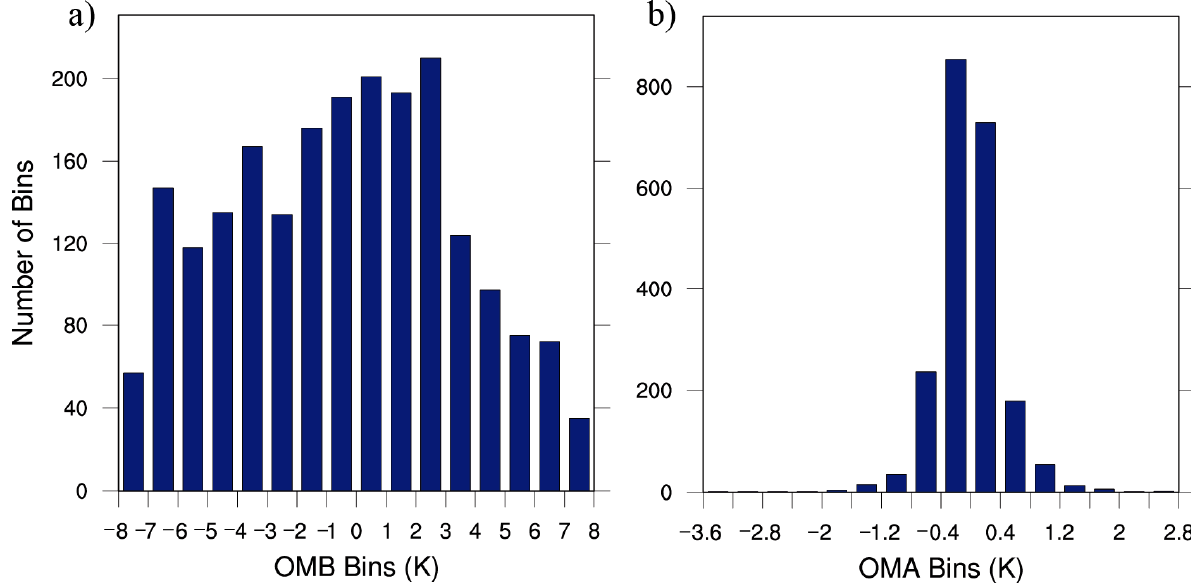
Figure 7. Scatterplots for MWHS-2 assimilation in ( a ) observation vs. background without BC, ( b ) observation vs. background with BC, ( c ) observation vs. analysis with BC, from channel 15, valid at 0600 UTC 8 August 2019.